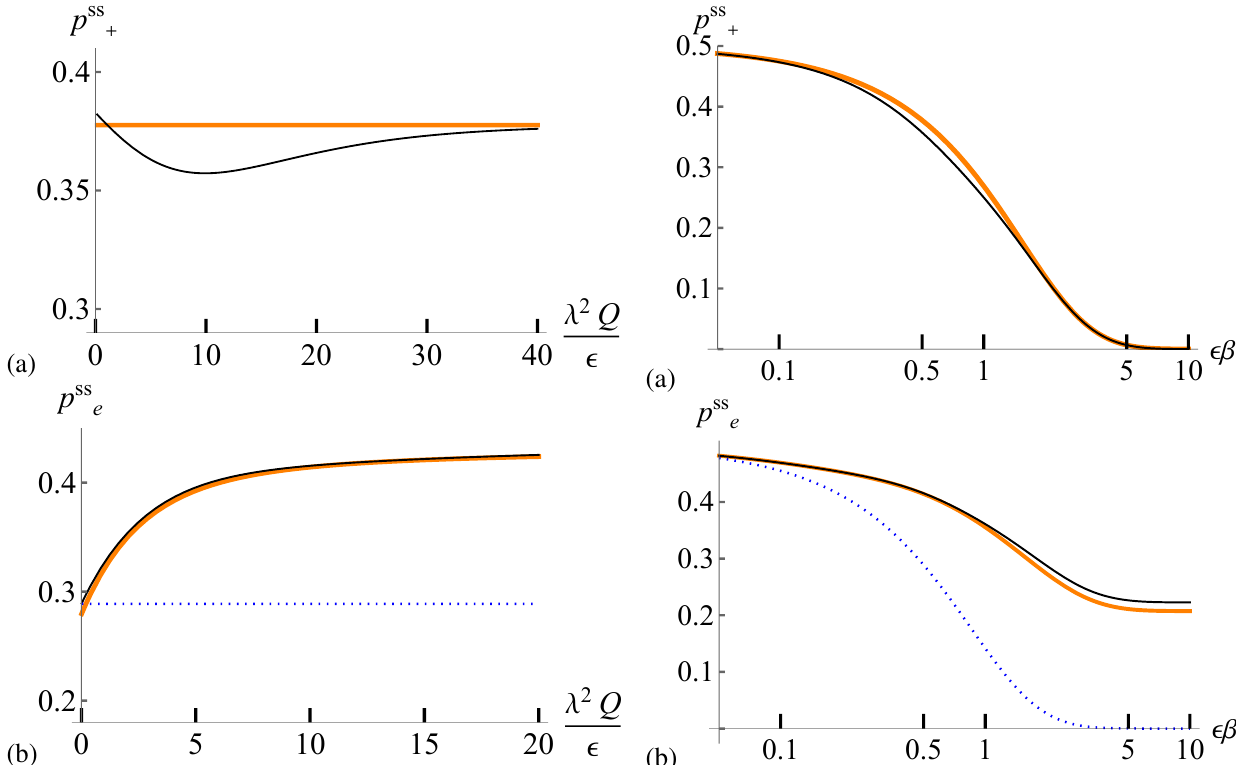
Figure 3: Plots of the mean force Gibbs state excited population Figure 4: Plots of the mean force Gibbs state excited pop- | + ⟩ in the eigenbasis of A, and (b) p ss (a) p ss + : = ⟨ + | ρ ss : = | + ⟩ in the eigenbasis of A, and (b) ulation (a) p ss + : = ⟨ + | ρ ss e S S ⟨ e | ρ ss | e ⟩ in the eigenbasis of H | e ⟩ in the eigenbasis of H p ss : = ⟨ e | ρ ss S , in function of the coupling S , in function of the in- S e S strength λ 2 Q in unit of ϵ , for ∆ = 1 . 5 ϵ and ϵβ = 0 . 5 . The verse temperature ϵβ in a semi-log scale, for ∆ = 1 . 5 ϵ and orange thick solid curve corresponds to the mean force Gibbs λ 2 Q = 10 ϵ . The orange thick solid curve corresponds to state excited population obtained in (33) , [44], and [25,46,47] the mean force Gibbs state excited population obtained in (all coinciding). The black thin curve corresponds to the excited (33) , [44], and [25, 46, 47] (all coinciding). The black thin population given by (40) . The blue dotted curve corresponds curve corresponds to the excited population given by (40) . The = to the thermal population in the vanishing coupling limit, p th blue dotted curve corresponds to the thermal population in the e = e − ω S β / (1 + e − ω S β ) e − ω S β / (1 + e − ω S β ) . vanishing coupling limit, p th e